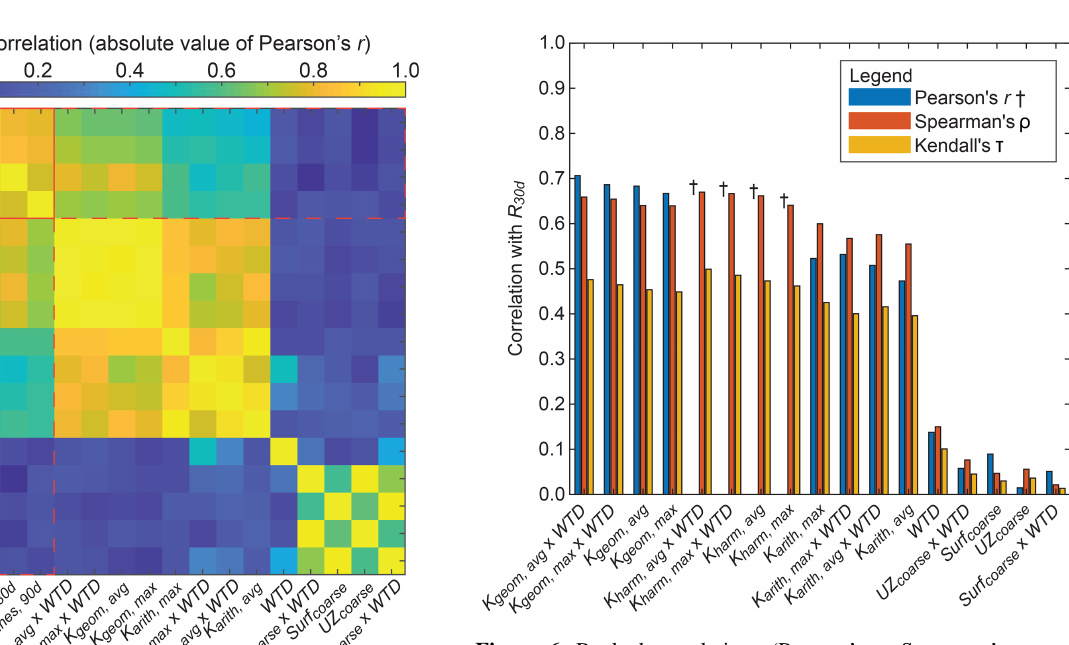
Figure 6. Ranked correlations (Pearson’s r , Spearman’s ρ , and Kendall’s τ ) of site characteristics with 30d average recharge rate ( R 30d ). † Pearson’s r was not evaluated for site characteris- tics where the normality of the distribution could not be improved with a log 10 data